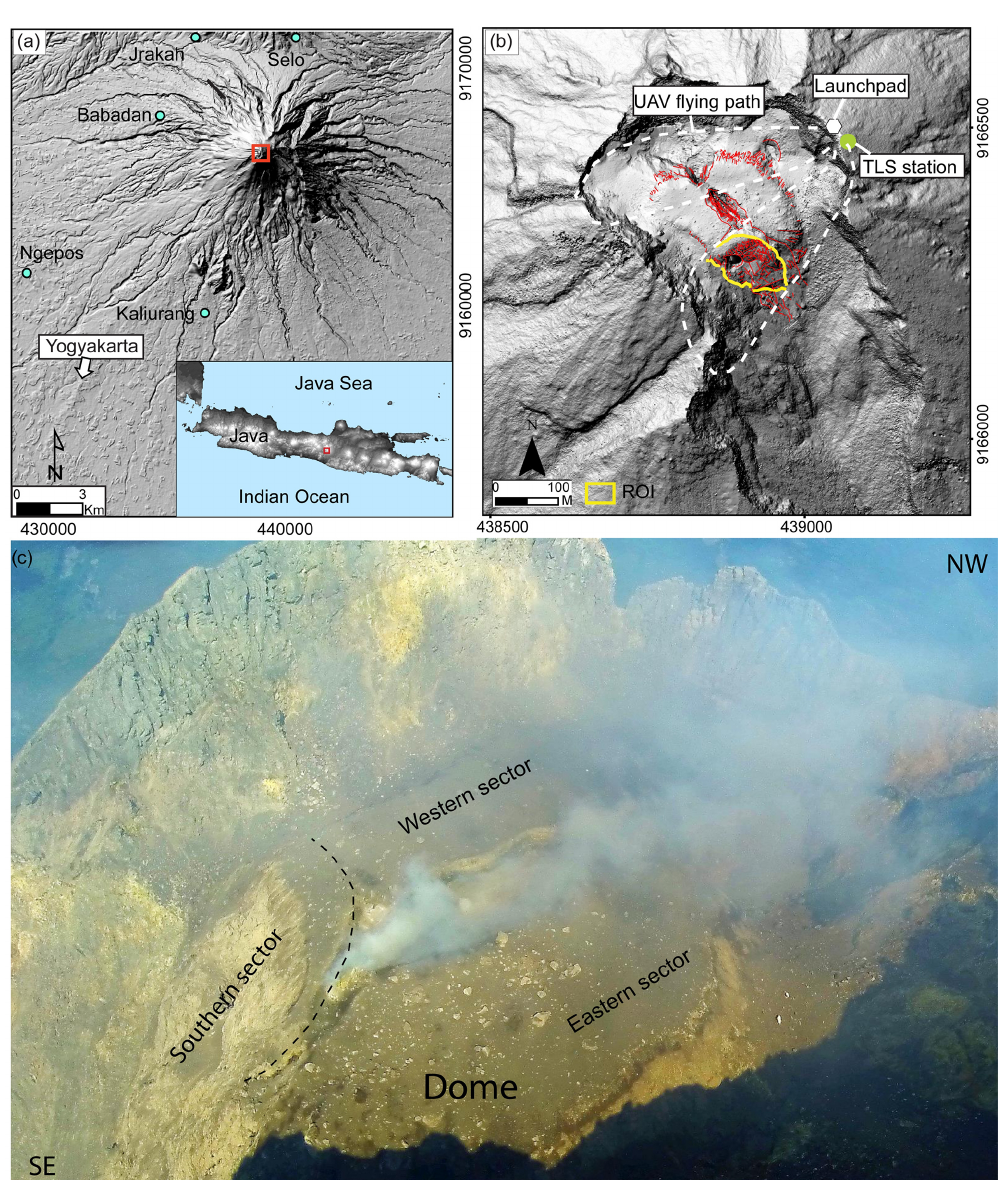
Figure 1. (a) Shaded relief of DEM from Gerstenecker et al. (2005) shows the morphology of Merapi volcano, the most active volcano in Indonesia. Merapi is located ∼ 30km from the densely populated city of Yogyakarta and therefore the activity of Merapi is intensively monitored by five observatories (blue dots). (b) TLS and drone photogrammetry field campaigns have been conducted in September 2014 and October 2015, respectively, to investigate the detailed structure and morphology of the Merapi lava dome. Coordinates are in Universal Transverse Mercator (UTM) meters. (c) The aerial image of the Merapi dome in 2014 shows the delineated unstable dome sector on the southern flank that is the focus of the present